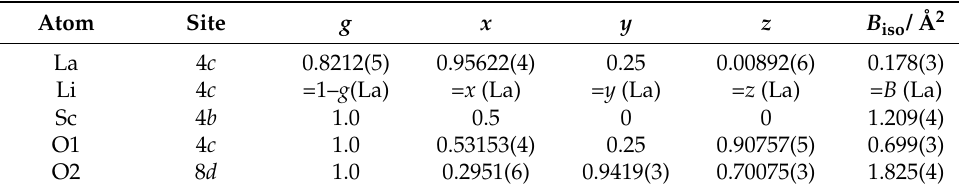
Table 4. Crystallographic parameters of the synchrotron diffraction data for (Li 0.45 La 0.78 Ce 0.05 )ScO